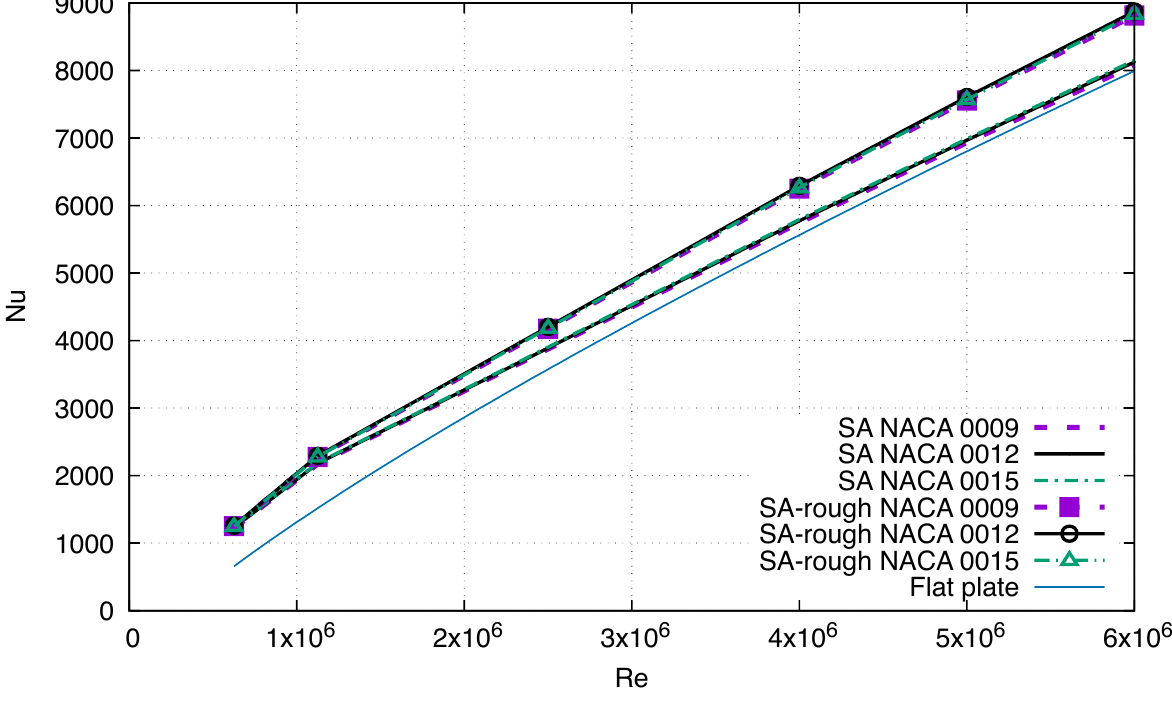
Figure 8. Nu function of Re : comparison between CFD results for the NACA 0009, the NACA 0012, and the NACA 0015 at α = 0. Smooth, rough airfoil, and smooth flat plate results. For symmetric airfoil, Nu should be maximum when α = 0 ◦ . As c l increases, the stag- nation point moves towards the pressure side and the curvilinear distance from the stagna- tion point to the trailing edge increases on the suction side. The thermal boundary layer becomes thicker on the suction side; thus, the heat transfer is reduced. This is observed on Figure 10a for the three airfoils at Re = 6 × 10 6 for both the smooth and rough surface. Nu for the NACA 0009 decreases faster with the lift coefficient than Nu for the thicker